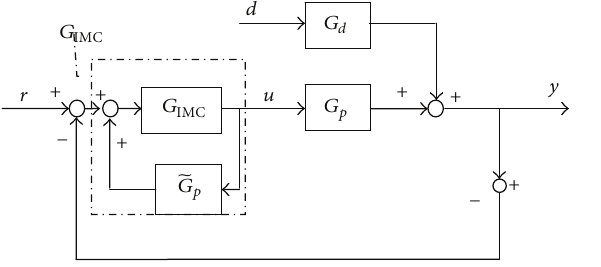
Figure 4: The equivalent IMC structure. Figure 5: Relationship between the IMC structure and the feedback control